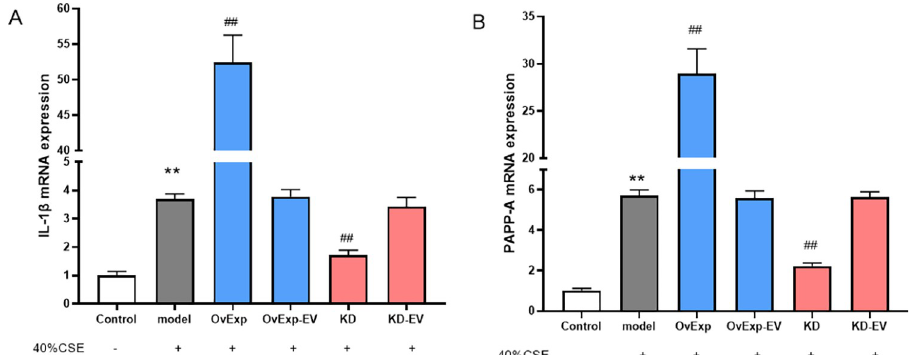
Fig 4. IL-1 β affected the expression of PAPP-A mRNA. The increased IL-1 β mRNA expression level was observed in model group, which was significantly reduced in IL-1 β knockdown group (A). The PAPP-A mRNA expression level was observed in model group, which was significantly downregulated by the IL-1 β knockdown (A) Results are represented as Mean ± S.E.M. �� P < 0.01 vs control; ## P < 0.01 vs model(n = 5).PAPP-A: pregnancy-associated plasma protein; OvExp: overexpression; OvExp-EV: overexpression empty vectors; KD: knockdown; KD-EV: knockdown empty vector.